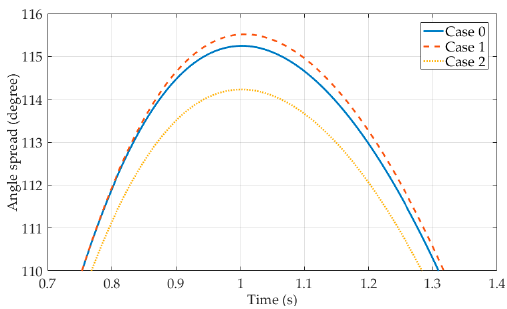
Figure 13. Detailed angle spread.